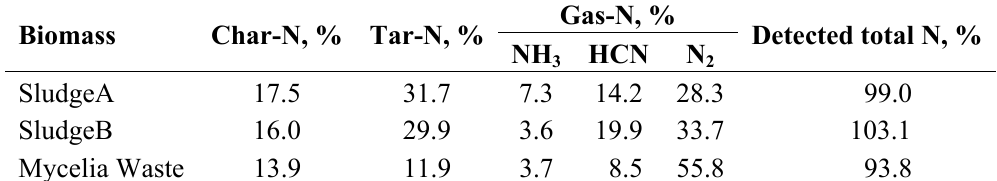
Table 3. Fuel-N distribution of biomass in the rapid pyrolysis at 800